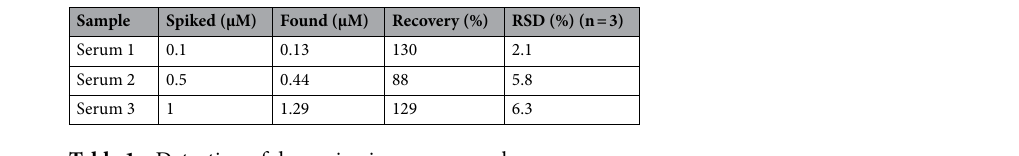
Supplementary Fig. S8b shows the DPV current response for sensor with PEDOT:PSS, Au, GO, and PEDOT:PSS composite at various concentrations of DA. The oxidation peak currents of DA were a linear func- tion of its concentrations ranged from 0.01 to 0.7 μM in PBS (pH 7.4). As shown in bottom table in Fig. S8, sensor with Au and electrode exhibited low linearity and relatively higher detection limit than that of GO/PEDOT:PSS,